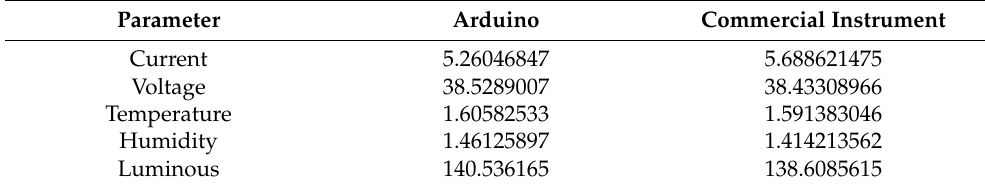
Table 6. Standard